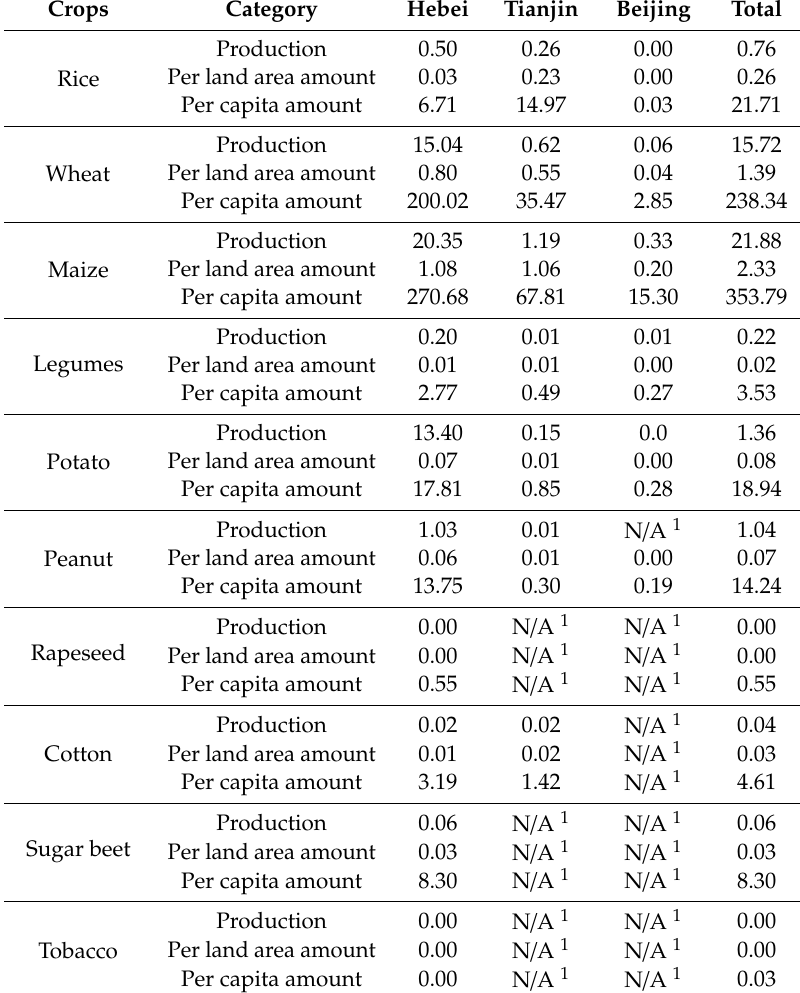
Table 2. Classified crops yield (10 6 tons), per land area amount of crops (10 6 tons) and per capita amount of crops (kg) of the Beijing-Tianjin-Hebei (H-B-T) region in 2017 (source: http: // www.stats.gov.cn /